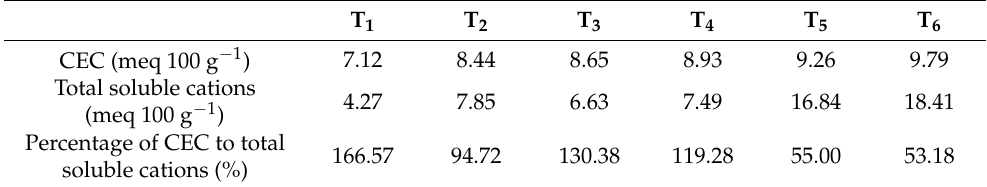
Table 5. Percentage of CEC in total soluble cations in 0–5 cm soil layer during the freeze–thaw